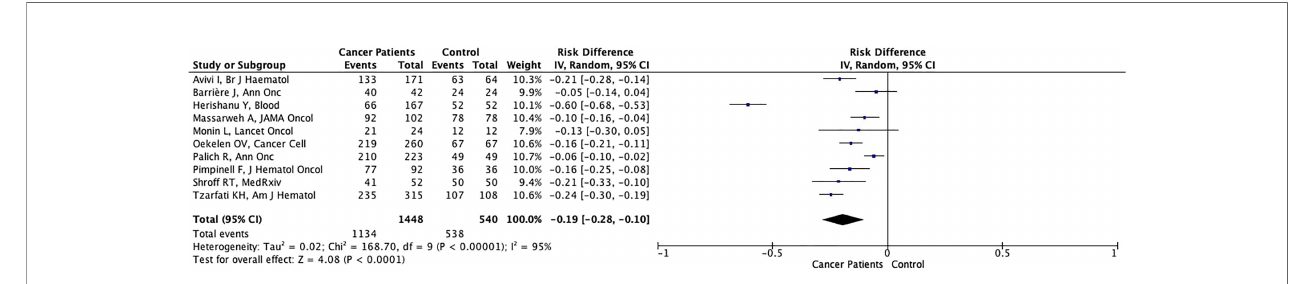
FIGURE 4 | Forest plot illustrating the risk differences of seroconversion rates between cancer patients and healthy controls after second dose of